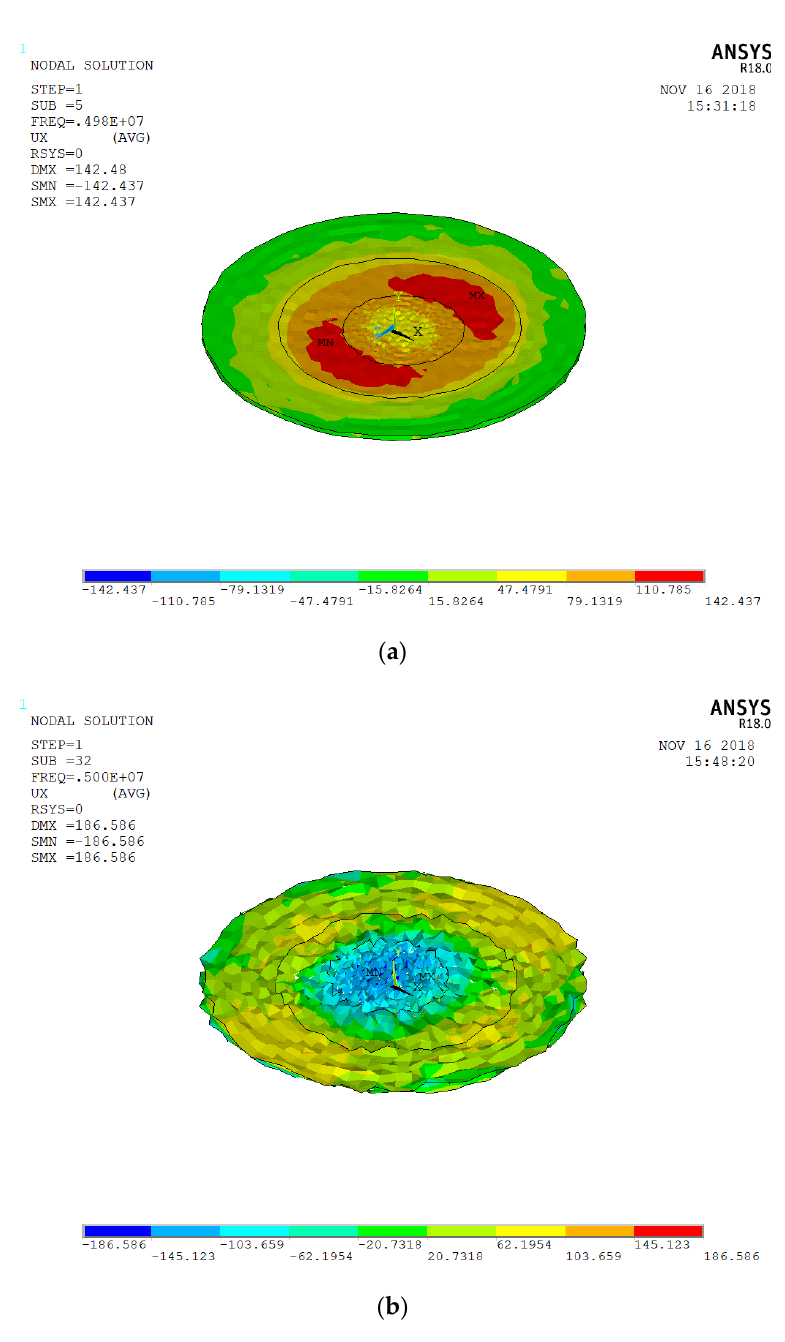
Figure 4. ( a ) The energy-trap graph corresponding to the external radius of 8 mm; ( b ) the energy-trap graph corresponding to the external radius of 10 mm.